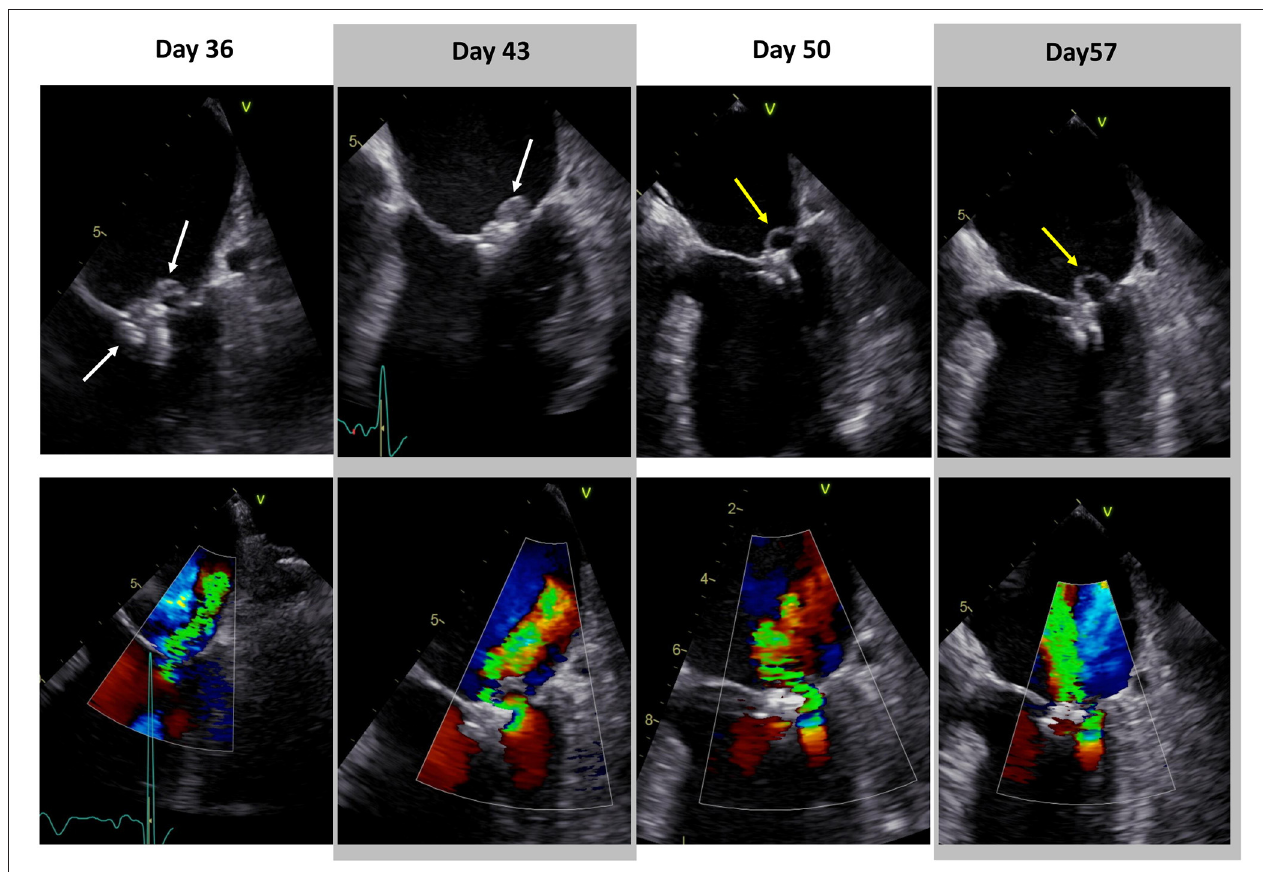
FIGURE 2 | Progress of infective endocarditis in transesophageal echocardiography. Transesophageal echocardiography of infective endocarditis at various timepoints during calculated antibiotic therapy. Day 0 = transcatheter mitral valve edge-to-edge repair. White arrows indicate vegetations. Yellow arrows show perforated posterior mitral leaflet and significantly reduced vegetation (Day 36: Supplementary Videos 3 , 4 ; Day 43: Supplementary Videos 5 , 6 ; Day 50: Supplementary Videos 7 , 8 ; Day 57: Supplementary Videos 9 , 10